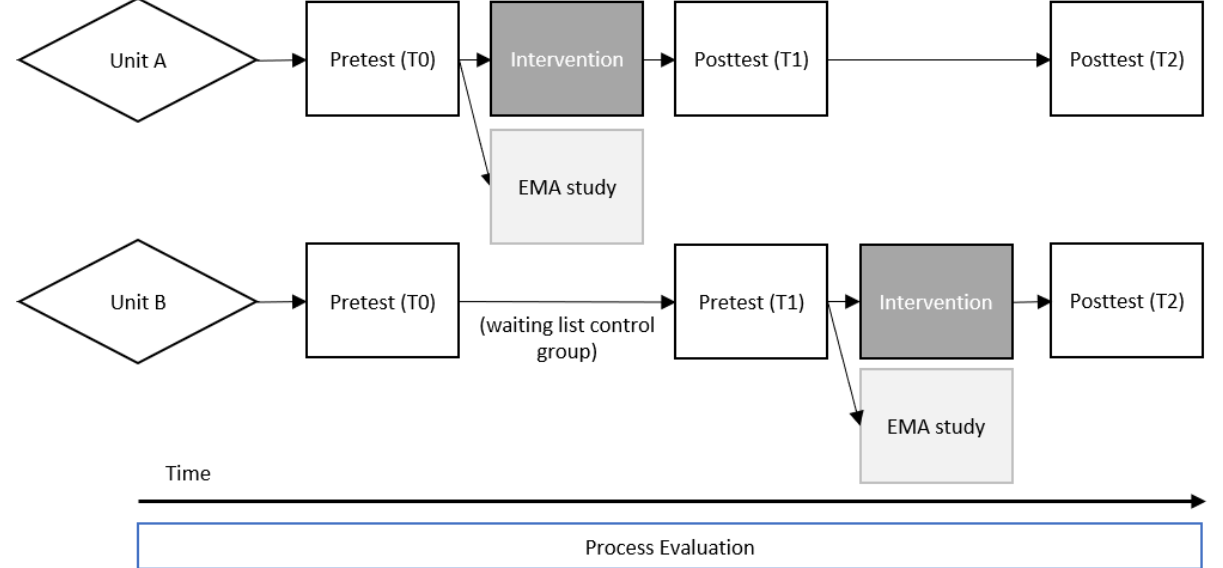
Figure 1. Study design. EMA: ecological momentary assessment; T0: baseline measurements; T1: measurements after 3 months; T2: measurements after 6